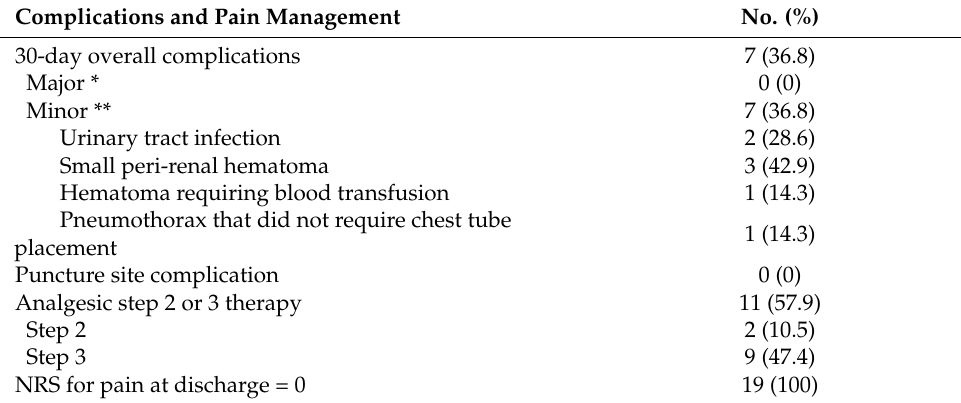
Table 5. Safety of selective arterial embolization prior to percutaneous cryotherapy in 19 patients: Complications, pain at discharge and analgesic